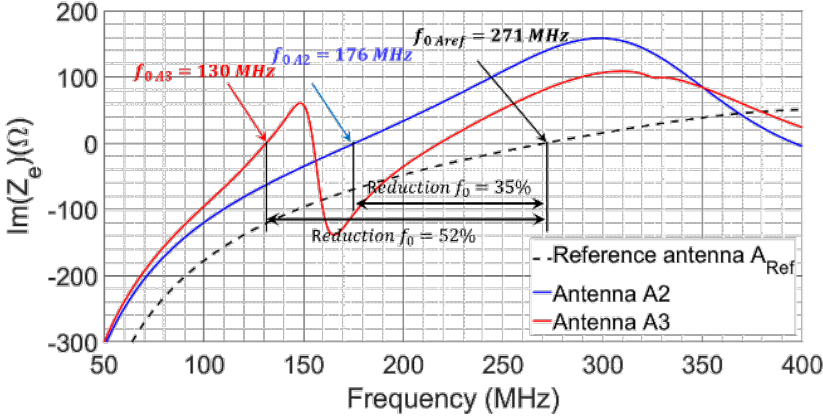
Figure 5. Imaginary parts of the input impedance of 3 antennas: A Ref , A2 and A3.